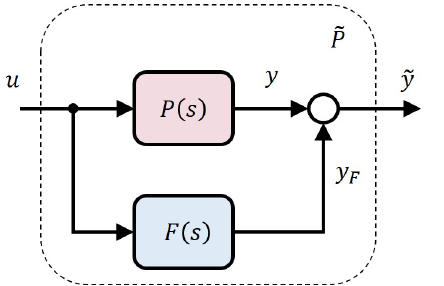
Figure 7. Parallel feed-forward interconnection: plant P ( s ) , PFC F ( s ) and extended plant ˜ P ( s )